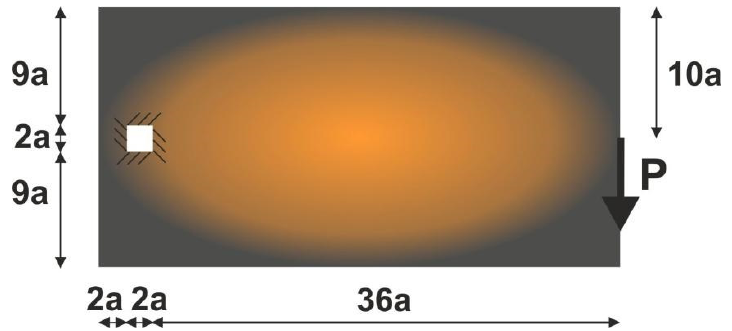
Figure 15. The test structure 3 with applied load and support.